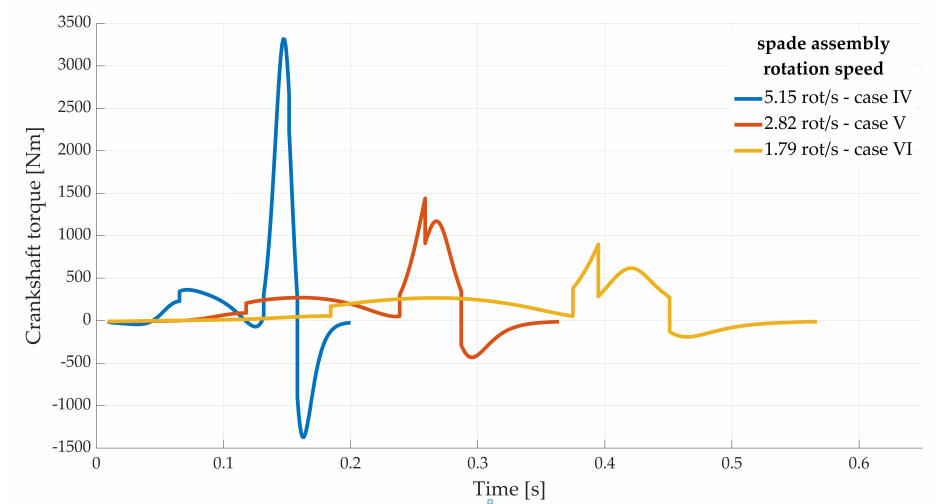
Figure 15. The overlapping effects of the bit, shear, and inertial loads on the crankshaft torques using working depth of 0.28 m and machine advancing speed of 0.35 m/s (first cycle